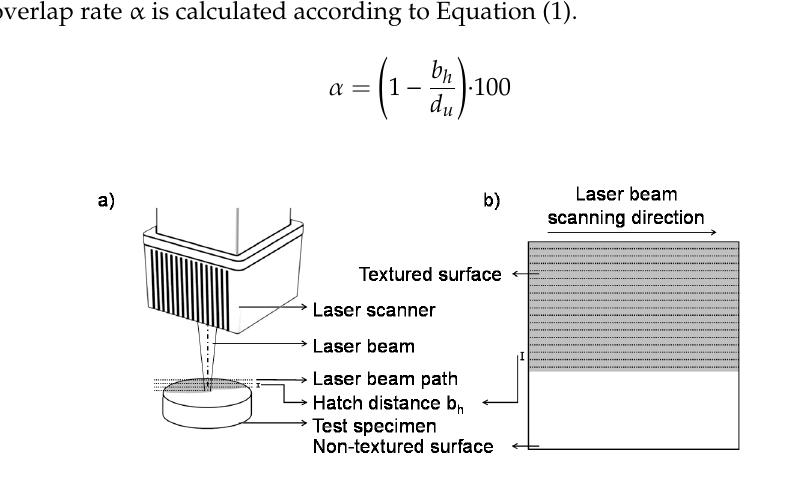
Figure 1. Schematic illustration of the experiments; ( a ) laser set-up to produce textured surfaces; ( b ) surface texturing according to the hatch distance b h.